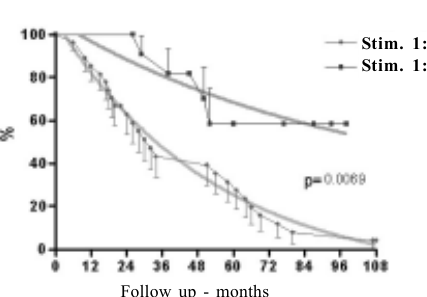
Stim. 1:1 Stim. 1:2